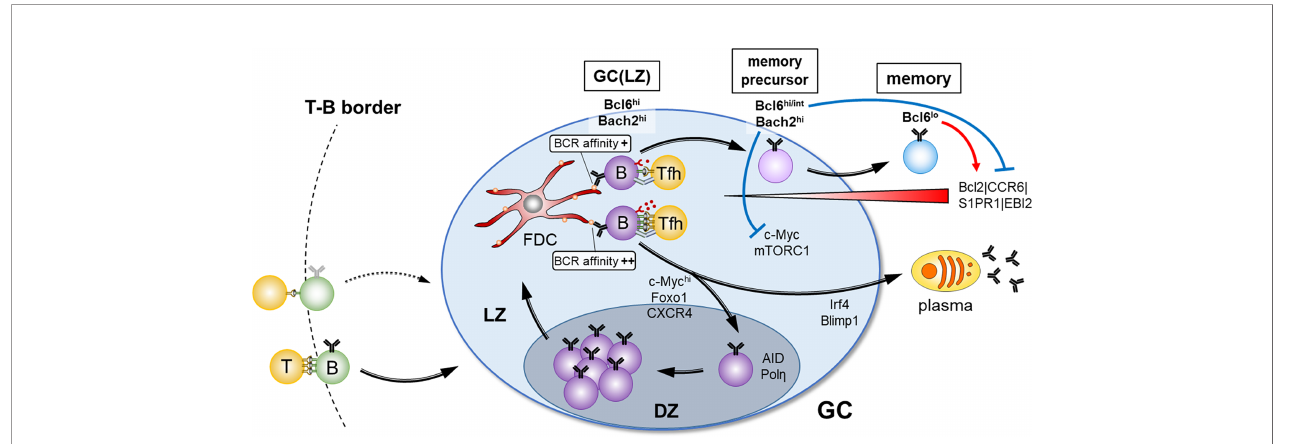
FIGURE 1 | Overview of the GC selection and the factors for memory B cell fate. After antigen-activated B- and T cell contact at the T-B border in secondary lymphoid organs, B cells enter into GC reaction. Clonal expansion and BCR diversi fi cation occur in the DZ, and af fi nity selection for the fate decision of B cell differentiation through interaction with FDCs and Tfh cells takes place in the LZ. Strong T cell help due to high BCR af fi nity determines the plasma cell fate or the reentry to the DZ, whereas weak T cell help due to low BCR af fi nity favors memory B cell fate. Suppression of mTORC1 activity and c-Myc expression mediated by high Bach2 expression, and a provision of survival signals mediated by down-regulation of Bcl6 are the key drivers for GC B cells to adopt a memory B cell